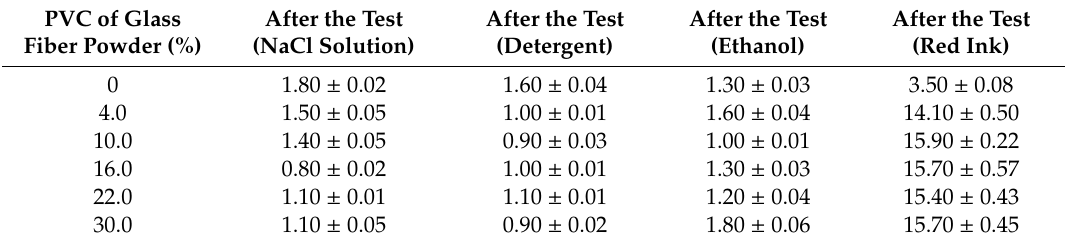
Table 8. Influence of the PVC of glass fiber powder on color di ff erence of thermochromic waterborne coating before and after liquid resistance.